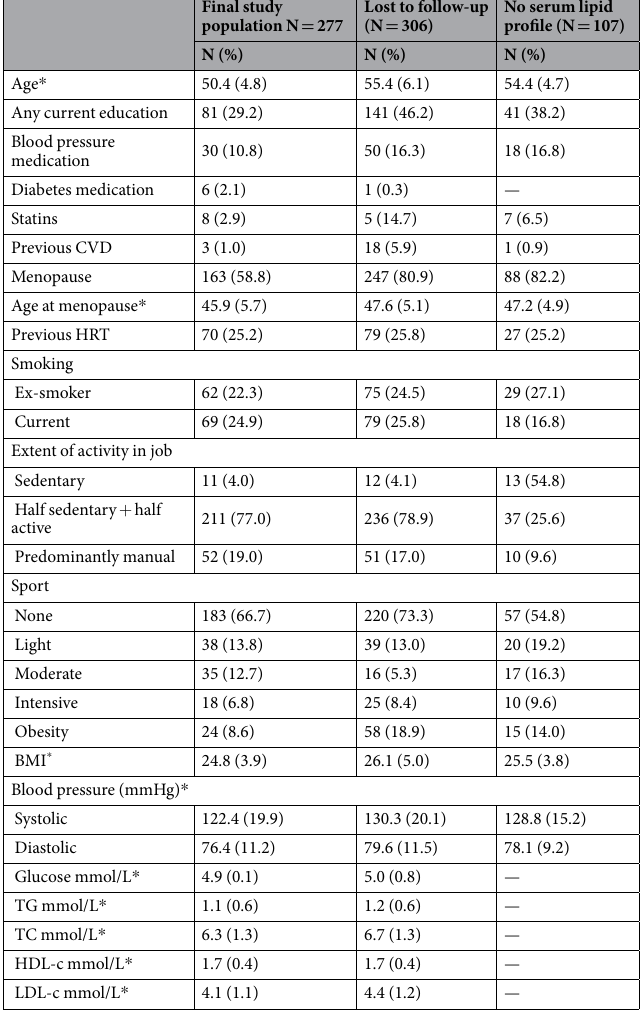
Table 1. Baseline characteristics of the study population. Numbers are percentages unless otherwise stated. * Mean (standard deviation). CVD: cardiovascular disease; HRT: hormone replacement therapy. TG: triglycerides, TC: total cholesterol, HDL-c: high-density lipoprotein cholesterol, LDL-c: low-density lipoprotein